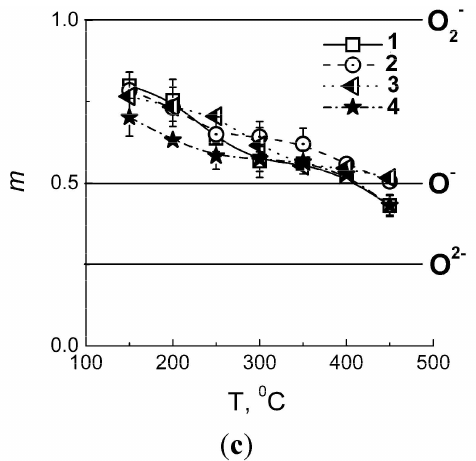
Figure 5. Resistance response to increasing O logarithmic conductance vs. oxygen partial pressure plot in coordinates of Equation (4) ( b ); and coefficient m (Equation (4)) attributed to the type of ionosorbed oxygen species as a function of operating temperature ( c ) for BaSnO